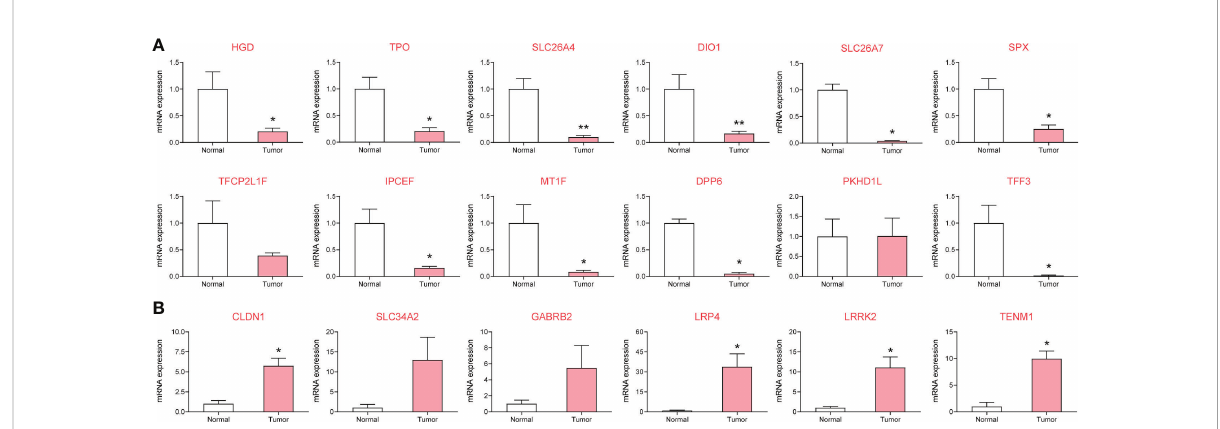
FIGURE 4 To investigate the expression of metastasis risk genes in papillary thyroid carcinoma (PTC) and adjacent clinical samples by RT-qPCR. 14 of which were signi fi cantly different. (A) DEGs downregulated in metastatic PTC compared with paracancellular tissues. (B) DEGs upregulated in